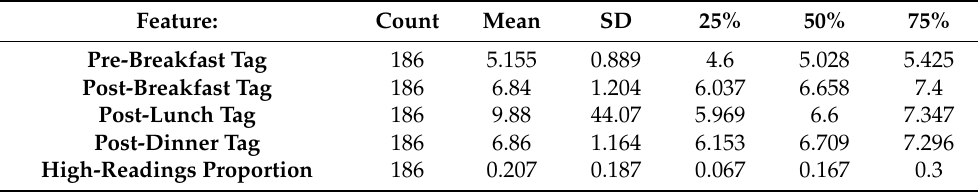
Table A2. RBH summary statistics for features used in model development. Population mean presented alongside standard deviation (SD) and 25th-, 50th-, and 75th-percentiles.